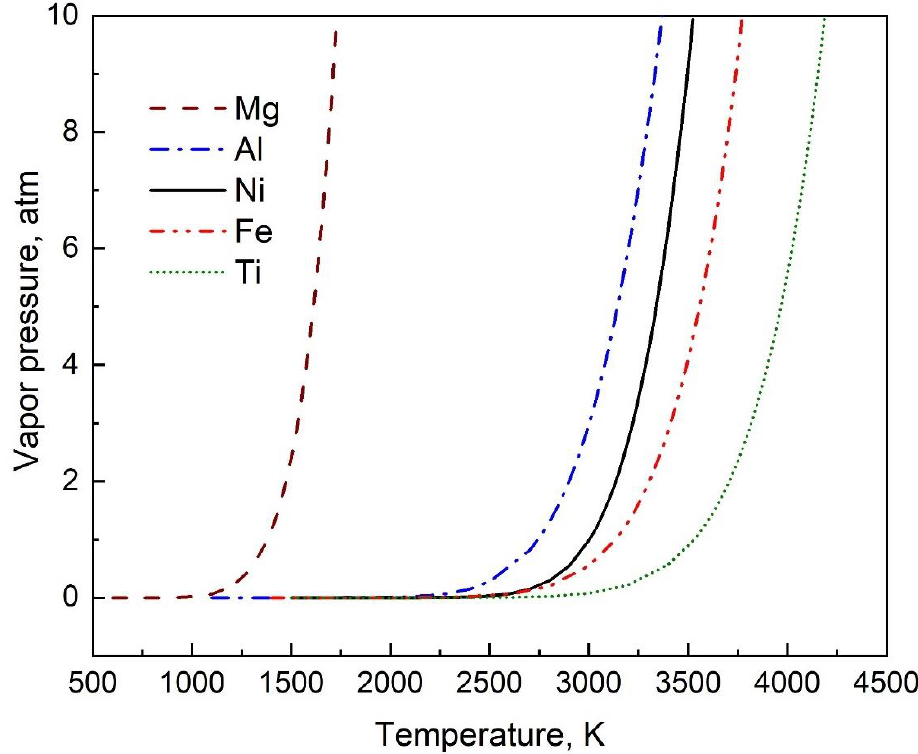
Figure 3. The variation of vapor pressure with temperature for five commonly used elements of Mg, Al, Ni, Fe, and Ti using the coefficients generated from this study (Table 2) in Equation (2).